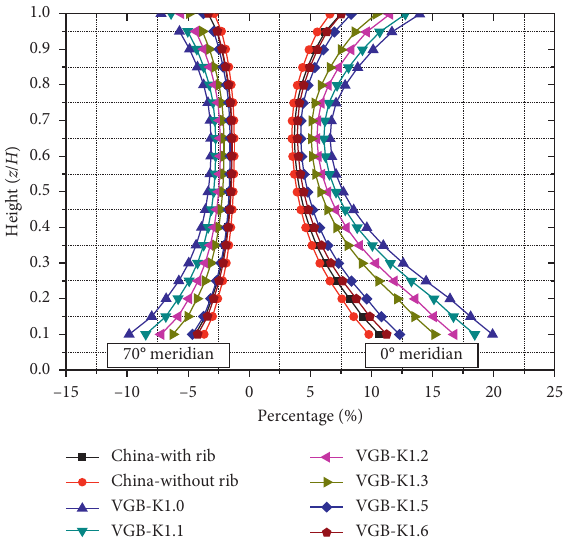
Figure 17: Percentage of first-order harmonic displacement.